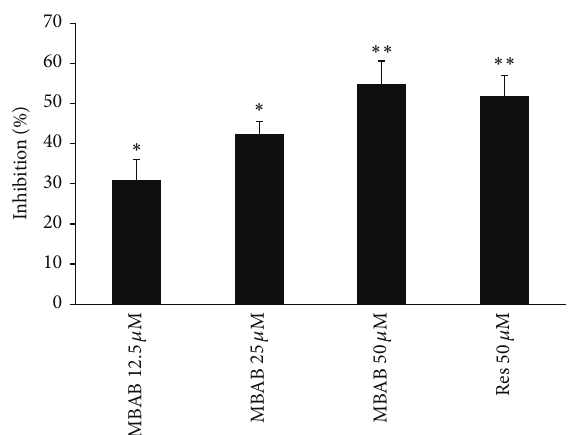
Figure 6: Inhibitory effect of MBAB on rosiglitazone induced PPAR- 𝛾 transcriptional activity. Res: resveratrol. The data are the mean ± SD values of the three experiments. ∗ 𝑃 < 0.05 , ∗∗ 𝑃 < 0.01 compared with the induction group